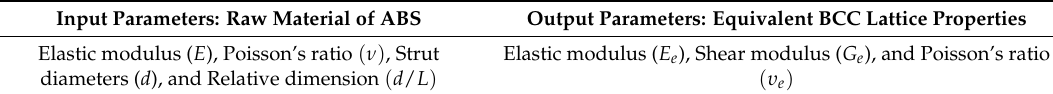
Table 3. Input/Output parameters for training and testing of BCC configuration.